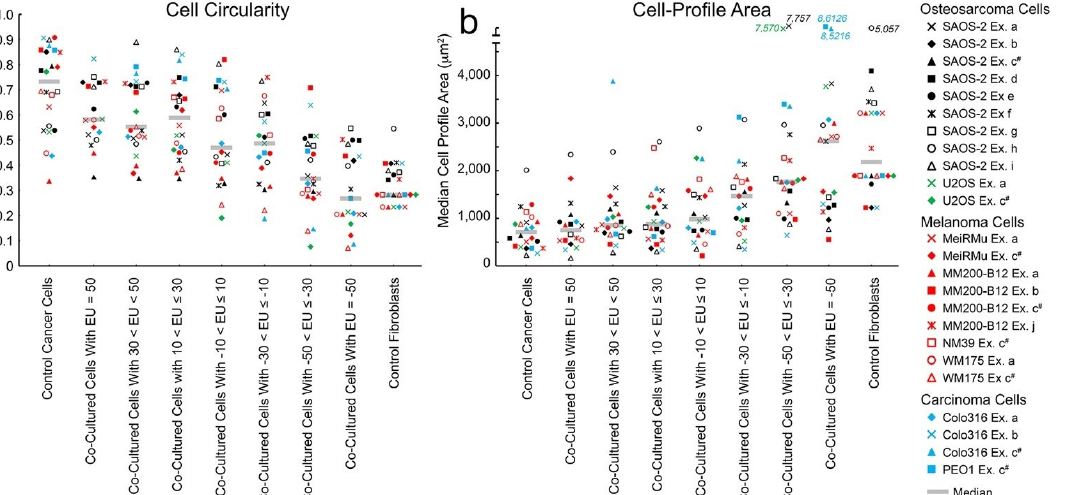
There was no statistically significant difference in cell-profile area between: control fibroblasts; co- cultured cells with fluorescence indistinguishable from that of control fibroblasts; and co-cultured fibroblasts with some cancer cell fluorescence. Co-cultured cells of uncertain origin had higher median cell-profile area compared with control cancer cells ( p < 0.0003, Wilcoxon signed-rank test), and lower median cell-profile area compared with: co-cultured fibroblasts with some fibroblast labelling; co-cultured cells with fluorescence indistinguishable from control fibroblasts; and with control fibroblasts ( p < 0.0001, Wilcoxon signed-rank test).